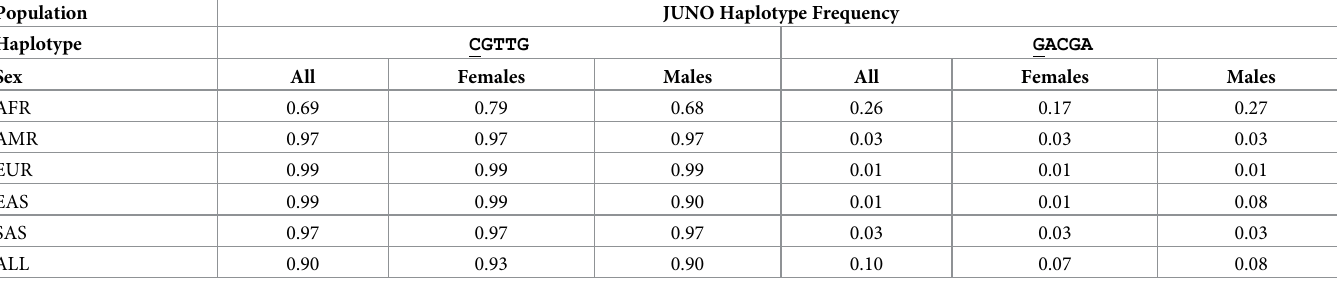
Table 3. The haplotypes and their haplotype frequencies in the JUNO gene (gene ID 390243) for both sexes analyzed together as well as separately in different popu- lation groups.